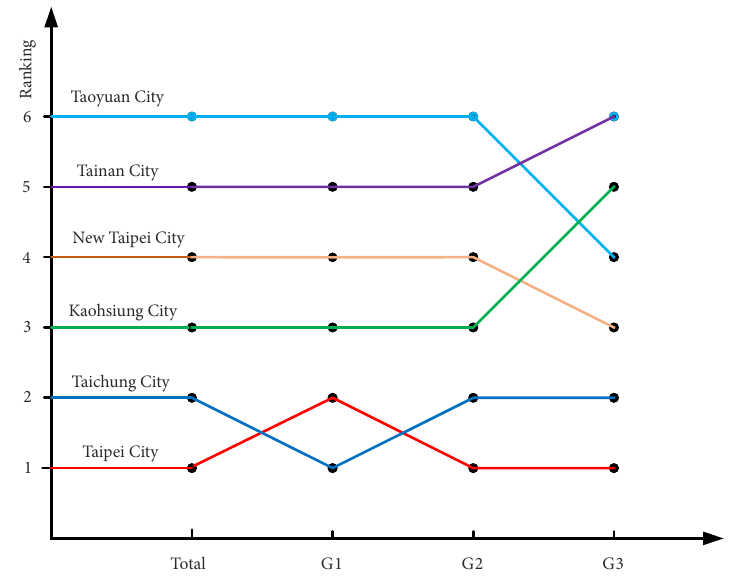
Figure 4. Ranking of the six cities for different groups in fundamental conditions